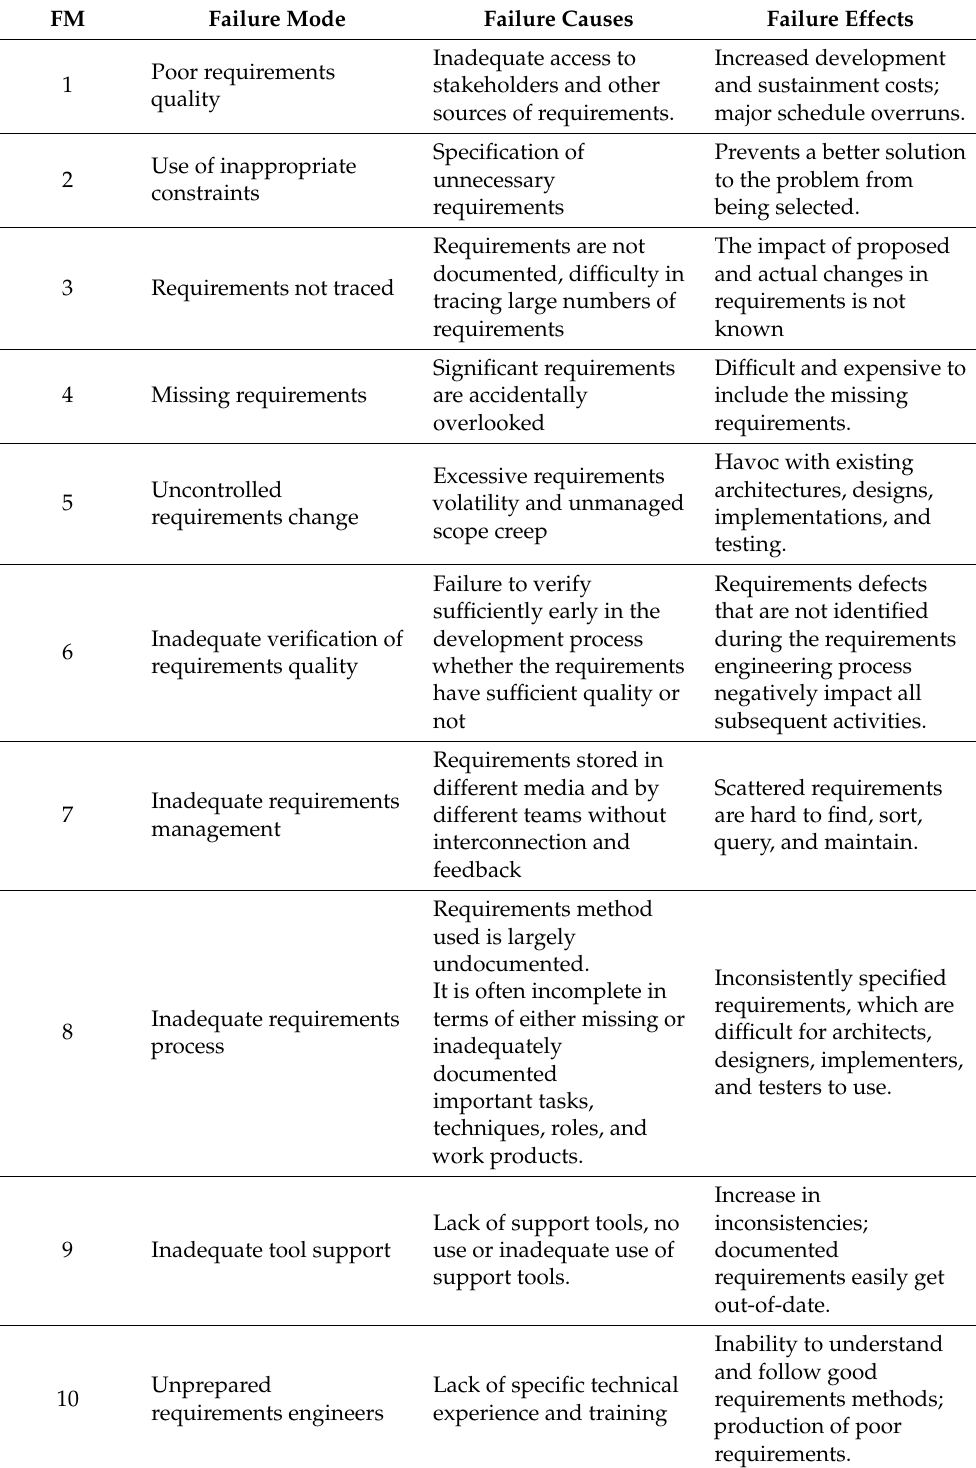
Table 3. Most common failure modes found in requirements identification process